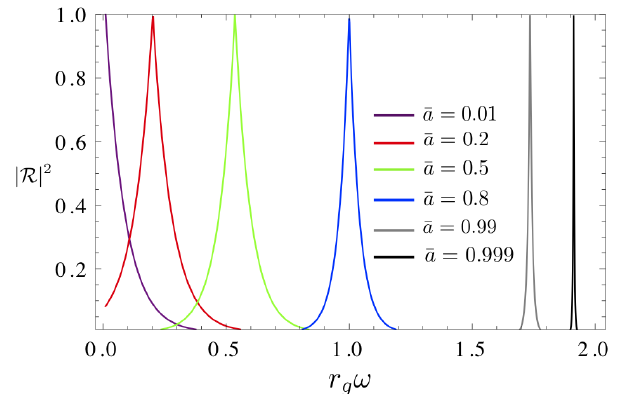
2 in the Boltzmann reflectivity |R|